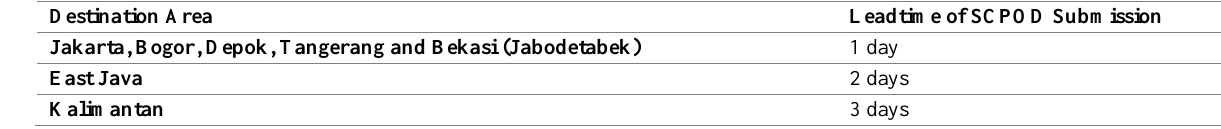
Table 1: Leadtime of SCPOD Submission based on Destination Area